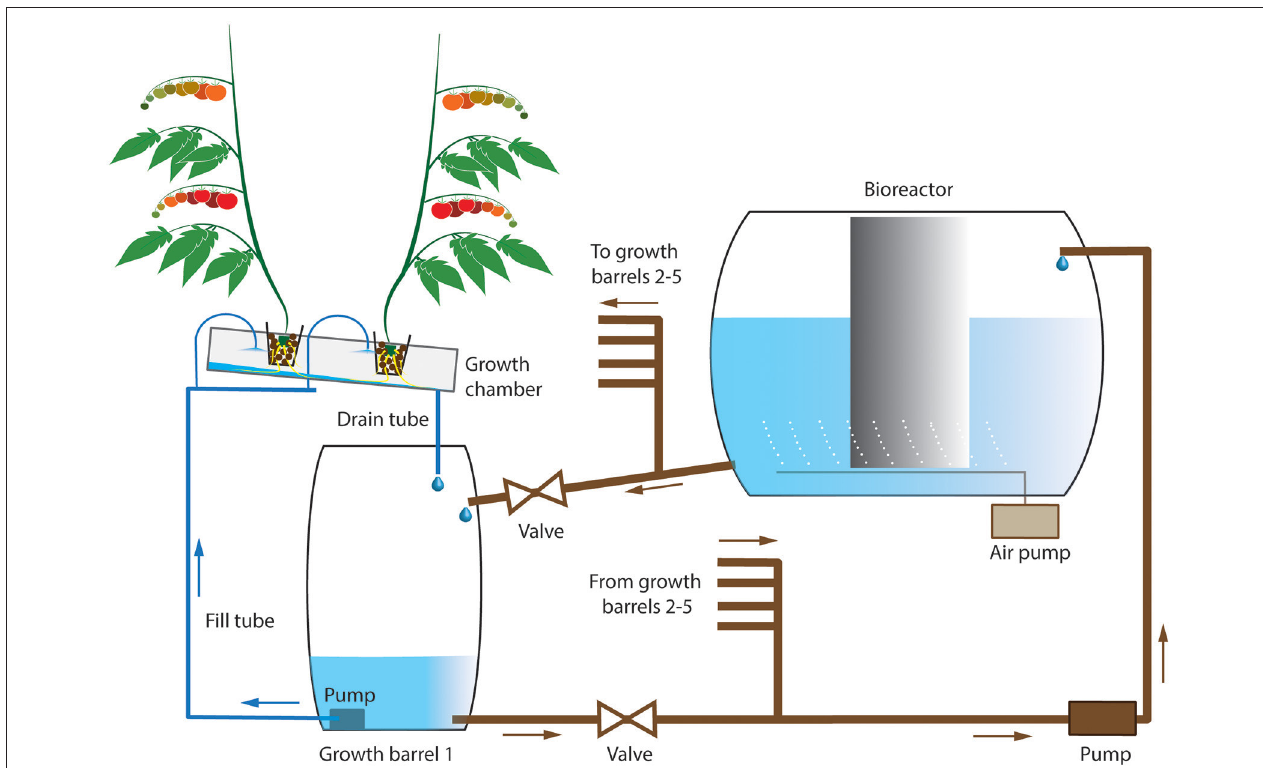
FIGURE 1 | Experimental setup for the organic waste-based and low-mineral treatments. The nutrient solution was mainly contained in a large reservoir (e.g., bioreactor) and gravimetrically transported to each of five growth barrels. The nutrient solution from each growth barrel was pumped into the growth chamber and sprayed on roots. The nutrient solution returned to the barrel through the drain pump, and was collected from all five pumps and returned to the large reservoir. For the high-mineral treatment, the large barrel was used instead of the bioreactor. The plants in rockwool cube were placed in expanded clay pebbles.